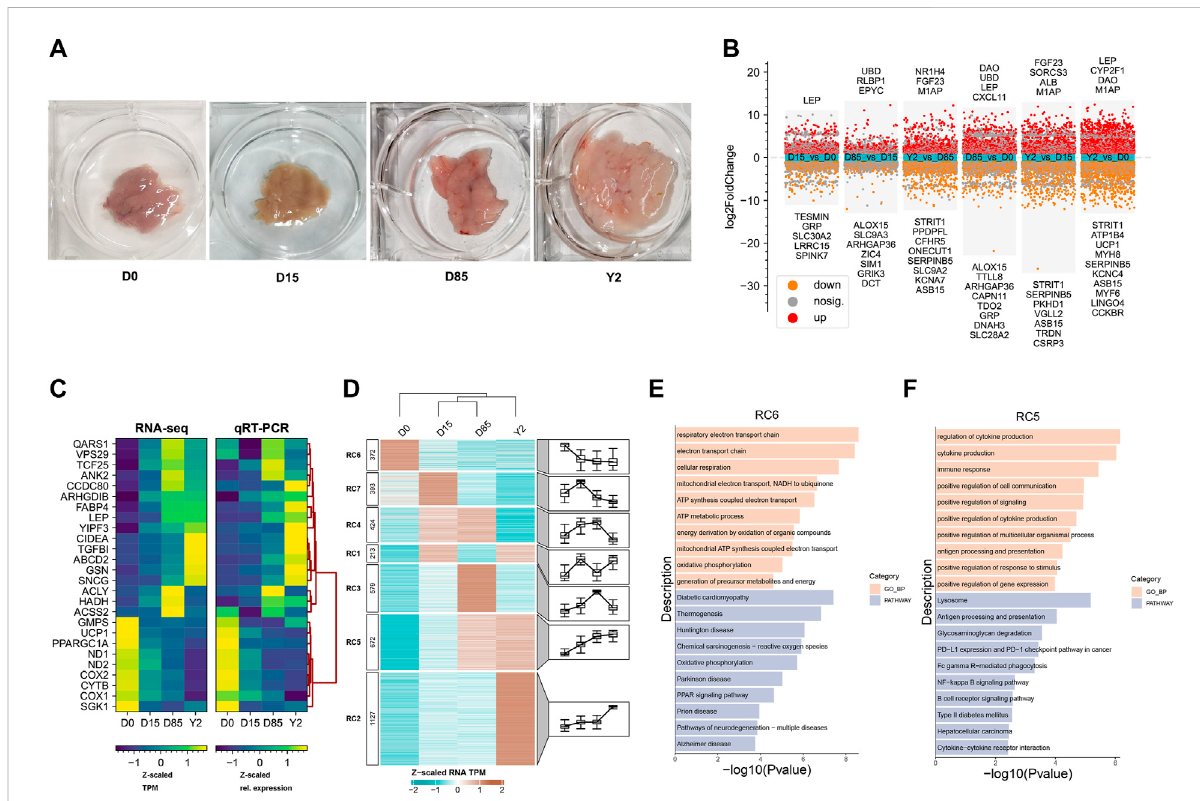
FIGURE 1 Transcriptomeanalysis ofBAT whitening inrabbits. (A) The appearance of BATsatfour stages. (B) Differential analysis ofthetranscriptome. The scatter plot show the genes with log2(FC) > 1 or log2(FC) < - 1. The red and orange points show the genes with FDR < 0.01. The grey points show the genes with FDR ≥ 0.01. The top 10 up- and downregulated DEGs that had been assigned of fi cial gene symbols were shown in corresponding directions. (C) qRT-PCR validation of selected genes in RNA-seq. The Ct-values of qRT-PCR are normalized to D0 and RN18S . Three independent samples are set per group and two technical replicates are set for one individual experimental replicate in qRT-PCR. (D) Heatmap analysis ofdifferentiallyexpressedgenes(DEGs)basedontheK-meansclusteringmethod.TPMvaluesofgenesareZ-scaled byrow.Theexpression patterns of DEGs in different clusters are shown in corresponding box-plots. The numbers of genes in different clusters are presented in the left annotation of the heatmap. (E,F) Bar plots show the top 10 enriched Gene Ontology enrichment in biological process category (GO-BP) terms and Kyoto Encyclopedia of Genes and Genomes (KEGG) pathways of genes in RC6 and RC2, respectively. Landscape and dynamics of chromatin accessibility during BAT